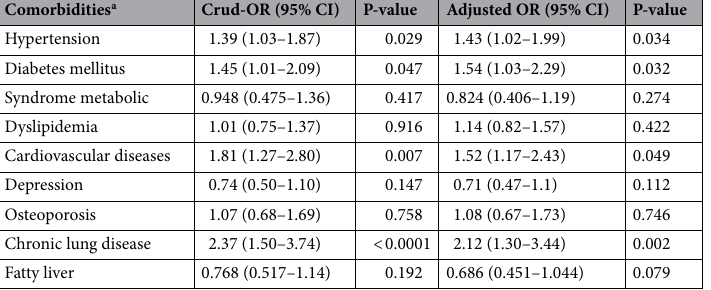
Table 3. Odds ratio (OR) of co-morbid illness adjusted for age, gender, education level, body mass index and smoking status for COPD in Shahrekord cohort study. OR: odds ratio; CI: confidence interval. a For each comorbidity, reference group was considered to lack of